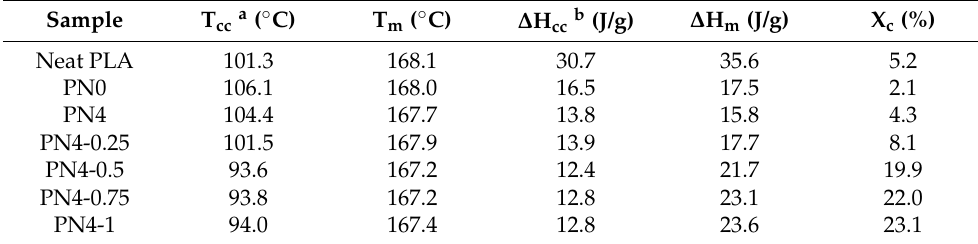
Table 4. DSC data of the PLA component derived from the DSC